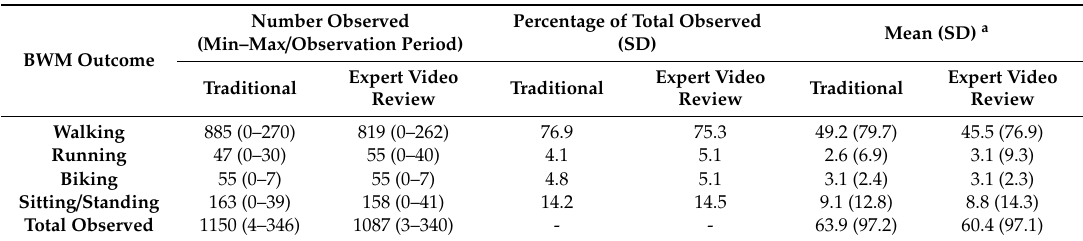
Table 1. Total numbers of individuals observed during traditional block walk methods (BWMs) and from expert reviews of BWM videos for each BWM outcome.